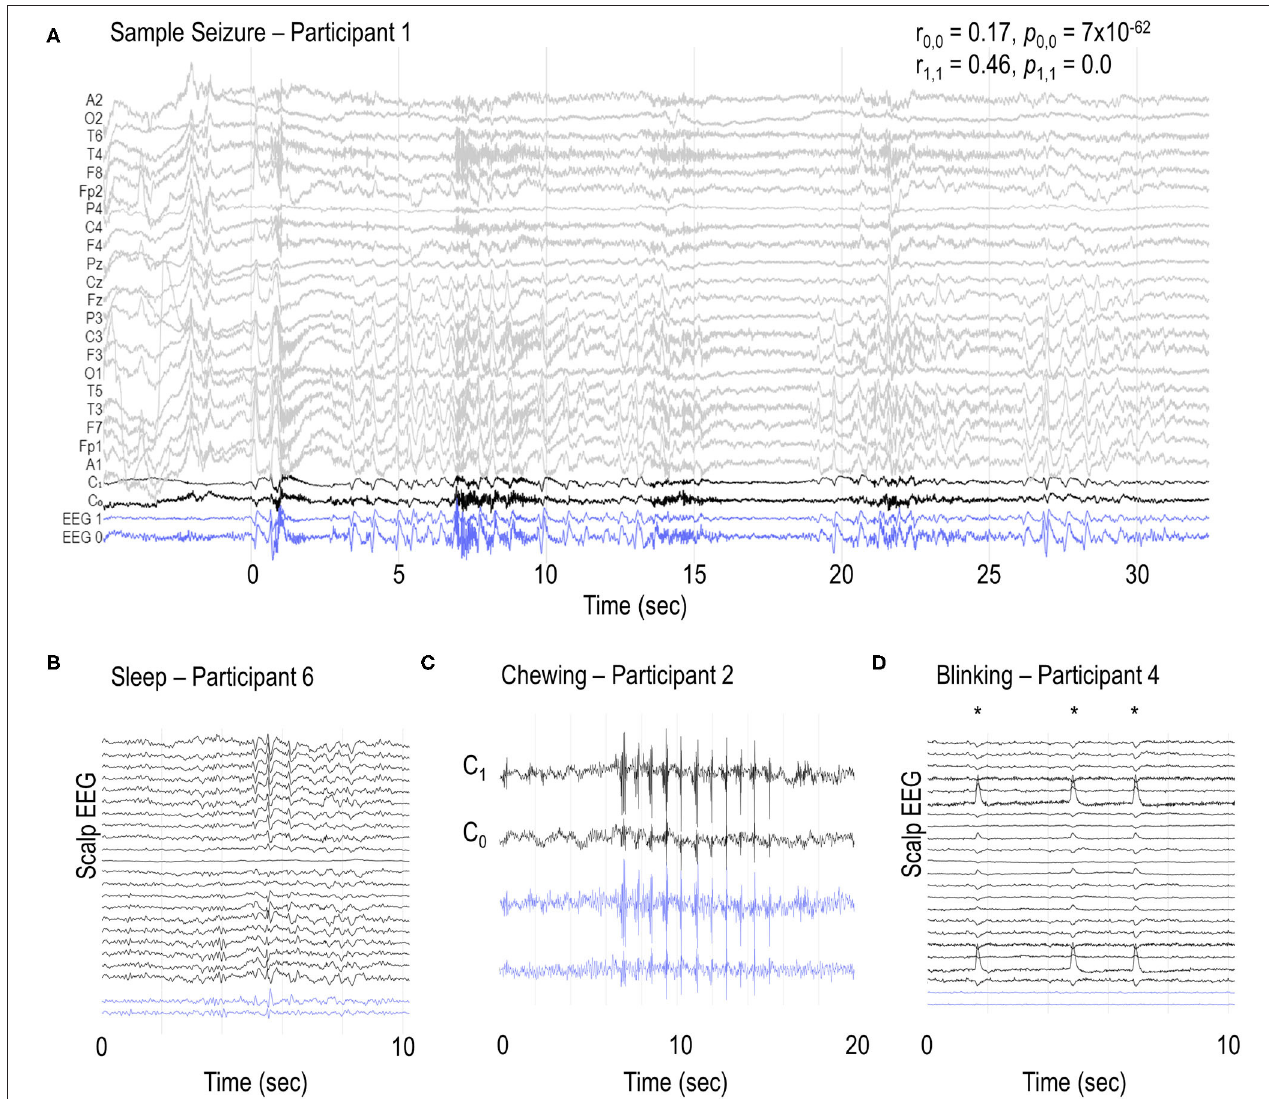
FIGURE 2 | Sample EEG recordings. (A) Sample seizure in participant 1 and examples of (B) vertex waves and spindles during sleep, (C) chewing and (D) blinking artifacts (*) in participants 6, 2 and 4, respectively. C 0 and C 1 channels represent the bipolar recordings from the additional scalp electrodes placed over the sub-scalp electrodes. Blue traces (EEG 0 and EEG 1) represent the sub-scalp recordings. r 0,0 and r 1,1 represent the Pearson correlation coefficient between C 0 and EEG 0, and C 1 and EEG 1, respectively. p 0,0 and p 1,1 represent the respective p values. Ambulatory scalp EEG and sub-scalp EEG recordings were reviewed